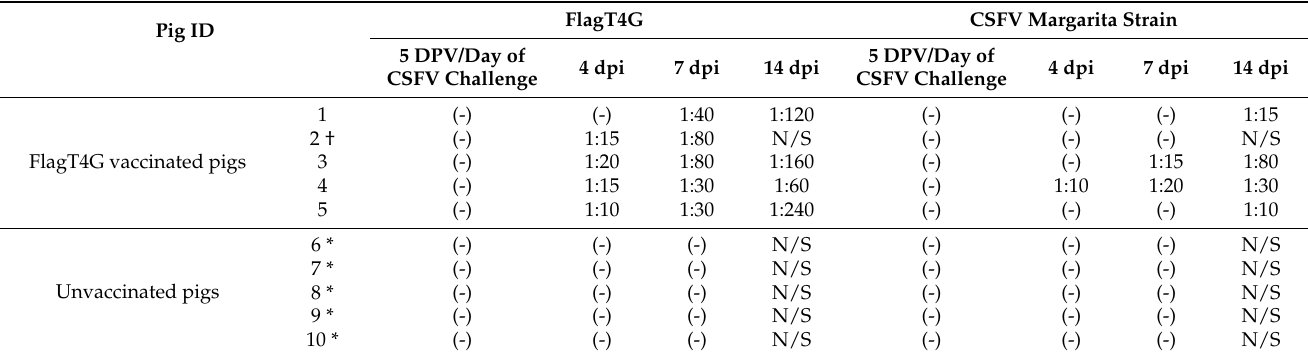
Table 1. Neutralizing antibody titers against FlagT4G and Margarita strain. Pig ID